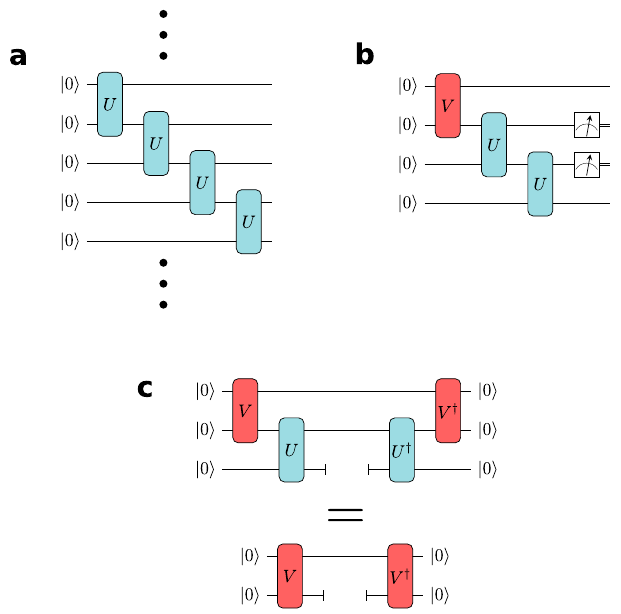
Fig. 6 | Finite circuit representation of iMPS states. a The iMPS state is formally represented by an in fi nitely wide and deep quantum circuit. b Local observables can be represented by a fi nite circuit by introducing the environment tensor V ≡ V ( U ). c V isdeterminedbythe fi xed-pointequationsshown,whichmaybeevaluated on